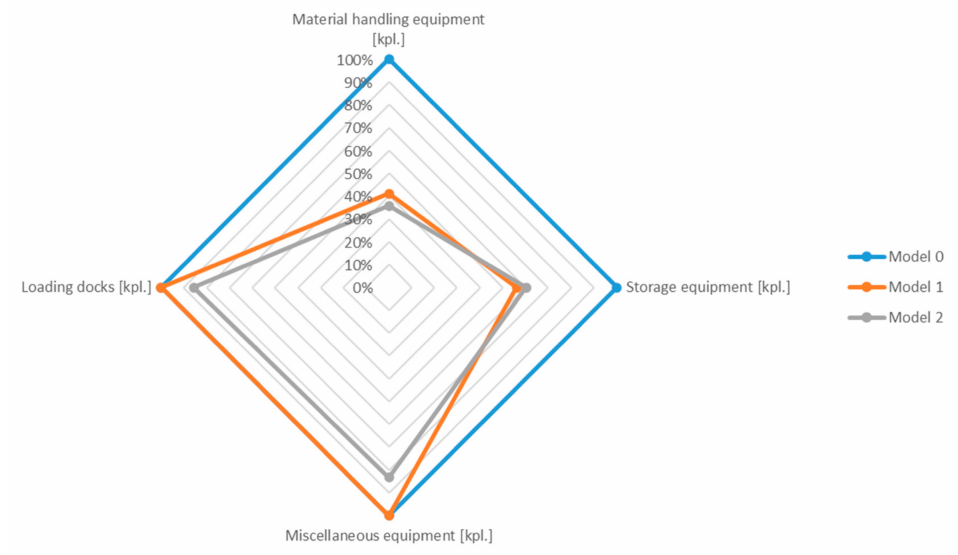
Figure 8. Results of the PL9A modeling of the Logistics System—Group 2—Logistics